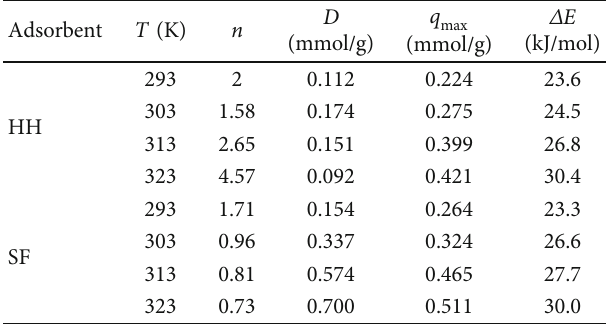
Table 6: Calculated statistical physics parameters for the Pb 2+ adsorption on HH and SF at pH